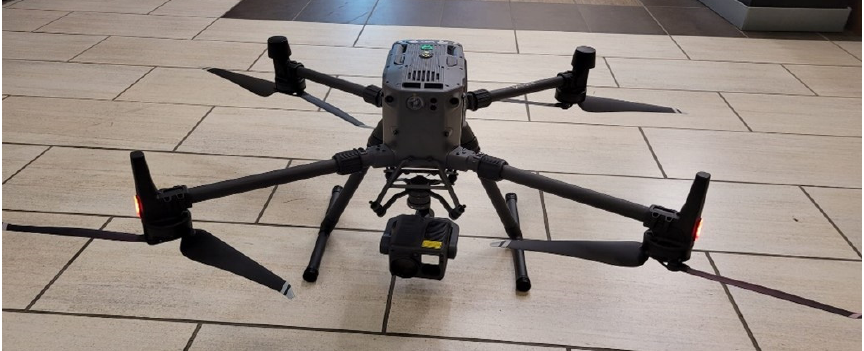
Figure 2. DJI Matrice 300 RTK drone and Zenmuse H20T camera .